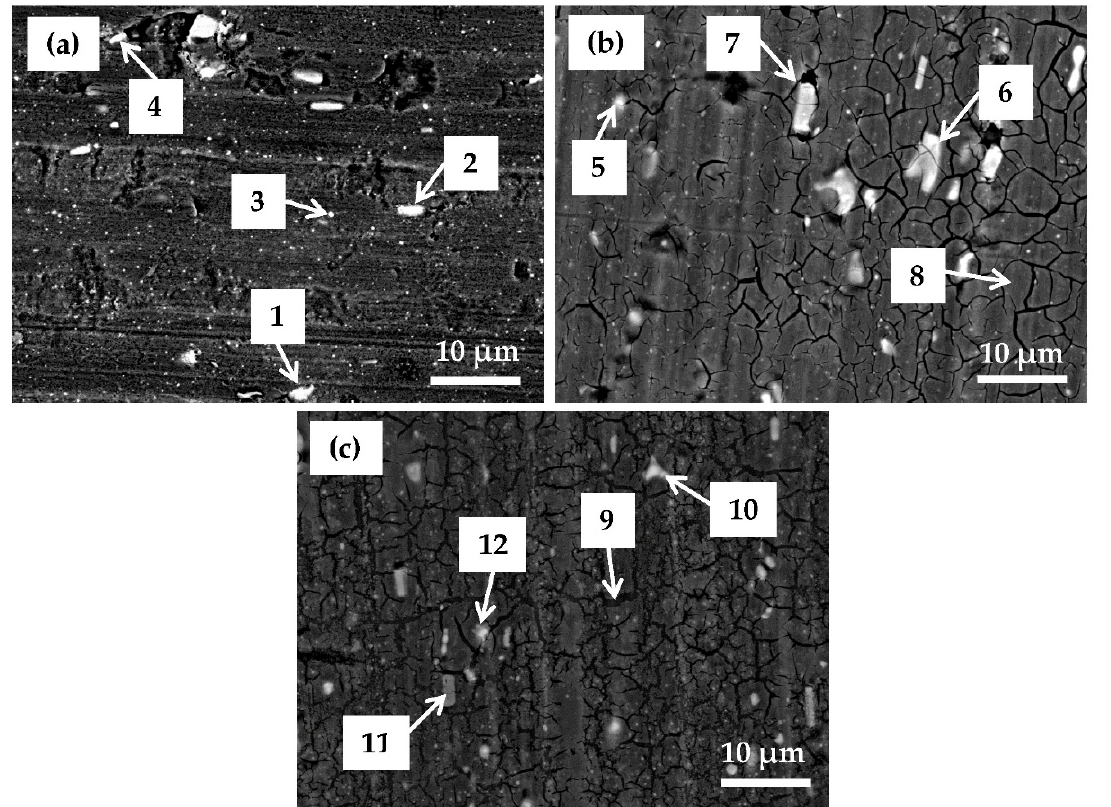
Figure 8. SEM backscattered electron micrographs for conversion coated AA3003 with different ST650 concentrations: ( a ) 10% ST650; ( b ) 25% ST650 and ( c ) 50% ST650. The conversion time was 18 min at room temperature. The enumerated spots are the locations at which EDS analysis was performed (Table 4). Table 4. The concentrations of elements obtained by EDS analysis of AA3003 coated with different concentrations of ST650 (Figure 8).